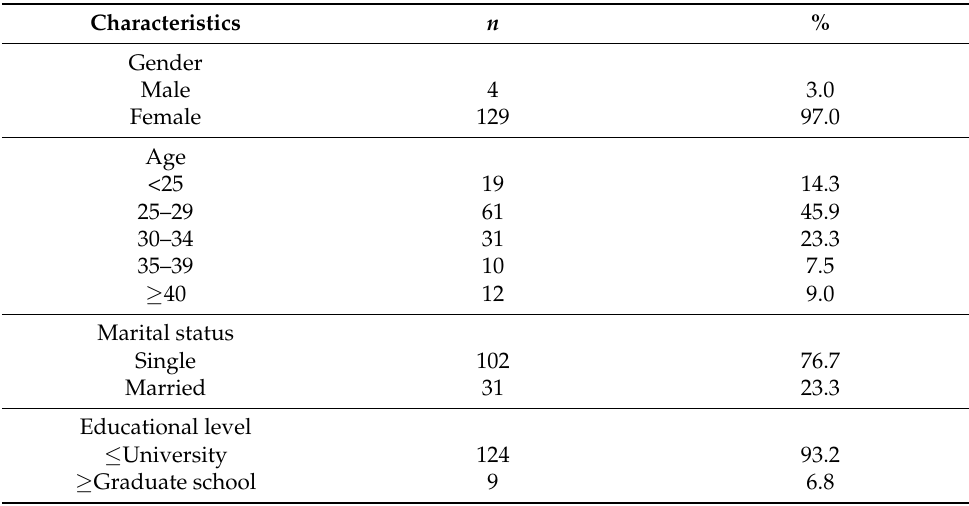
Table 1. General characteristics of the study